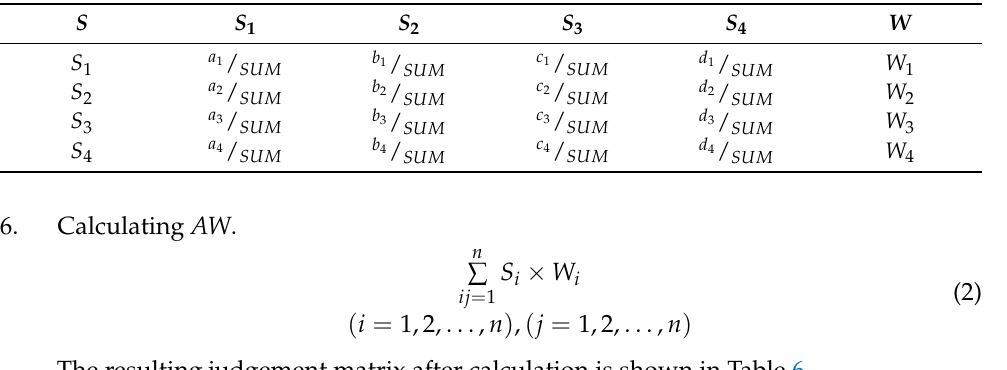
Table 5. Judgement matrix after calculation.